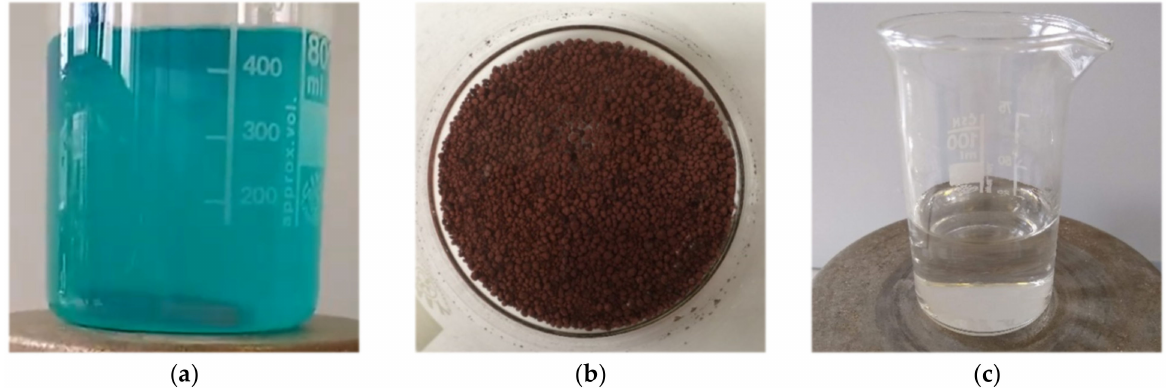
Figure 12. ( a ) Input solution with pH 4 ( b ) zinc powder after cementation ( c ) solution after pH adjustment and